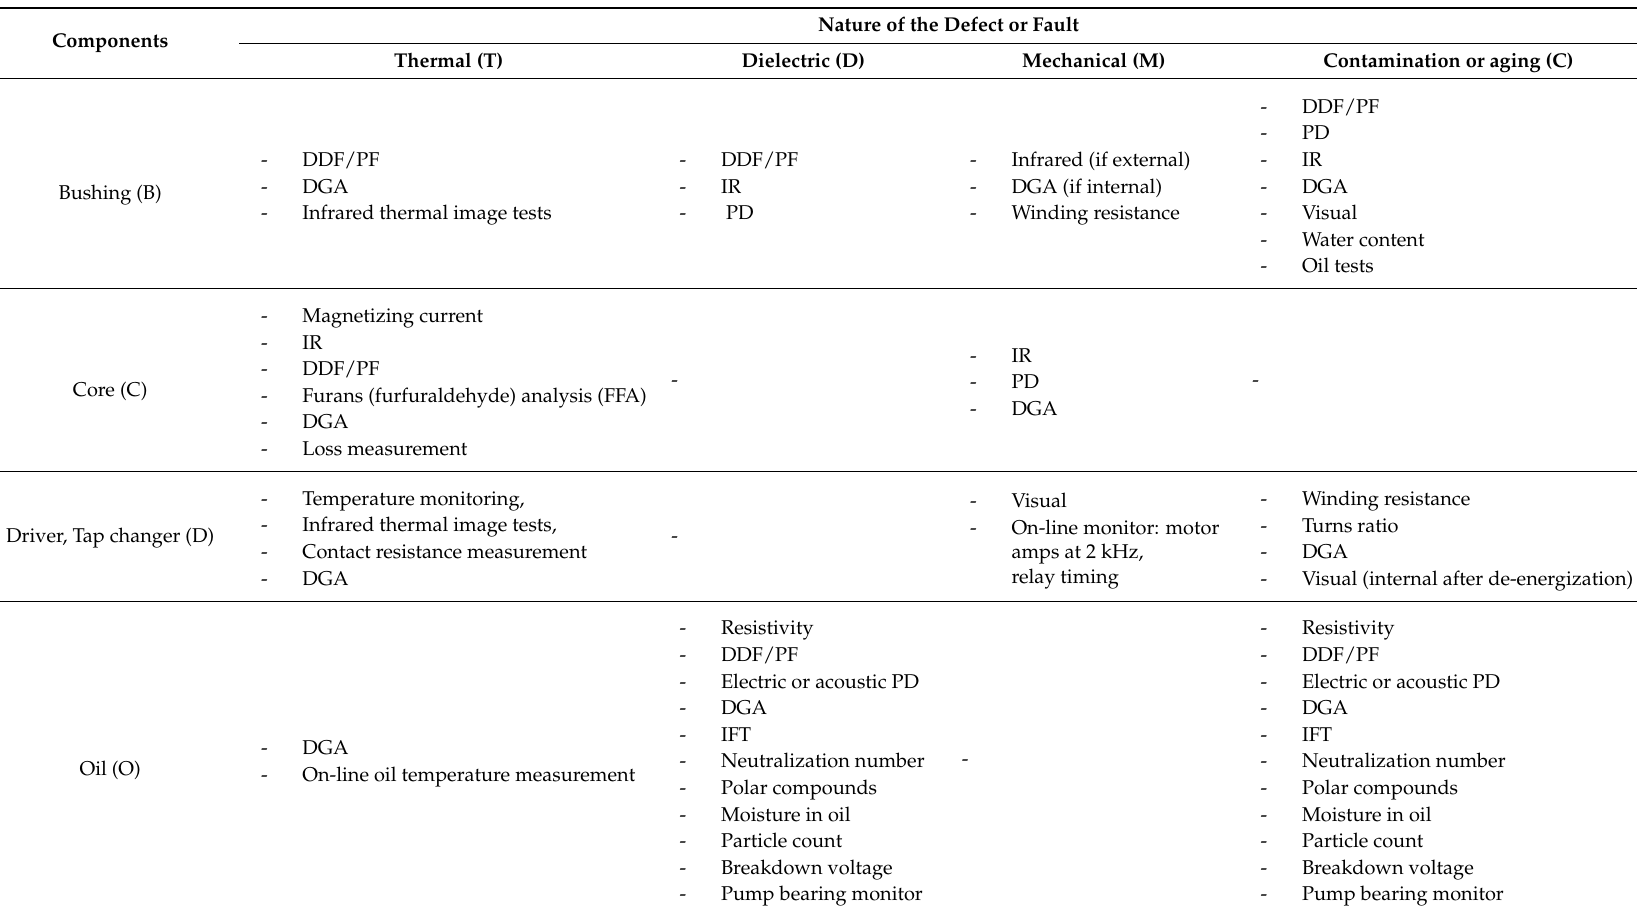
Table 1. Graphical suggestions/recommendations related to the nature of the defect or fault in power transformer’s main component, adapted from [137]. Non-electrical-based techniques are in red. IR: insulation resistance; DDF: dielectric dissipation factor; DGA: dissolved gas analysis; IFT: Interfacial Tension; DRA: dielectric response